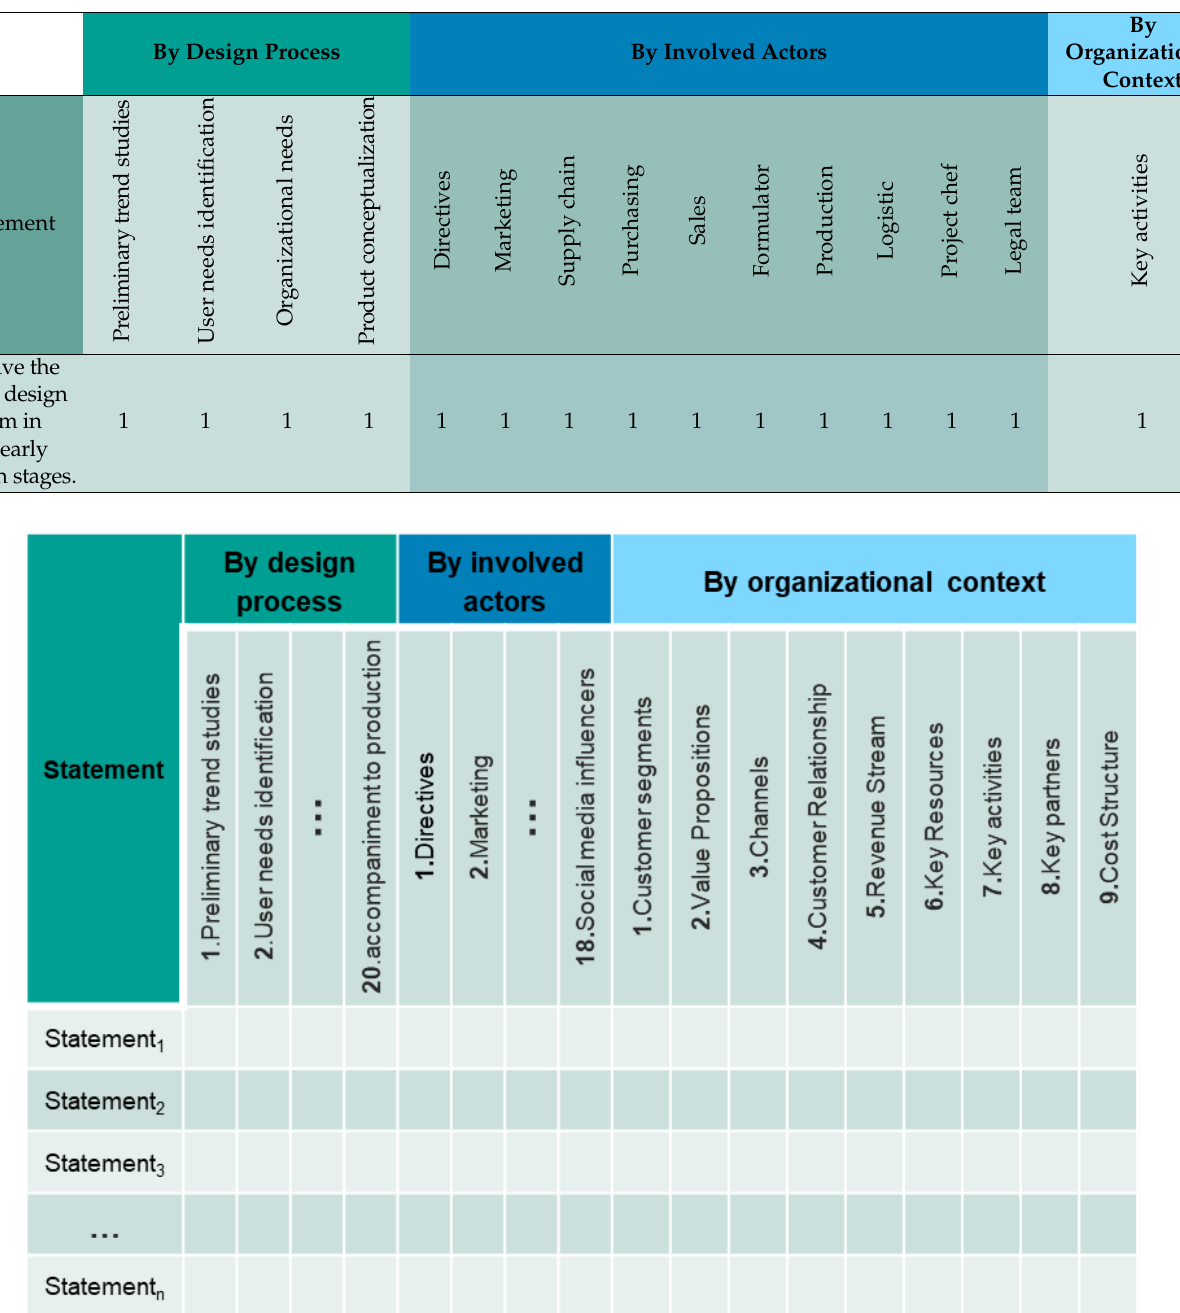
Table 4. Example 1 of expert statement formalization.